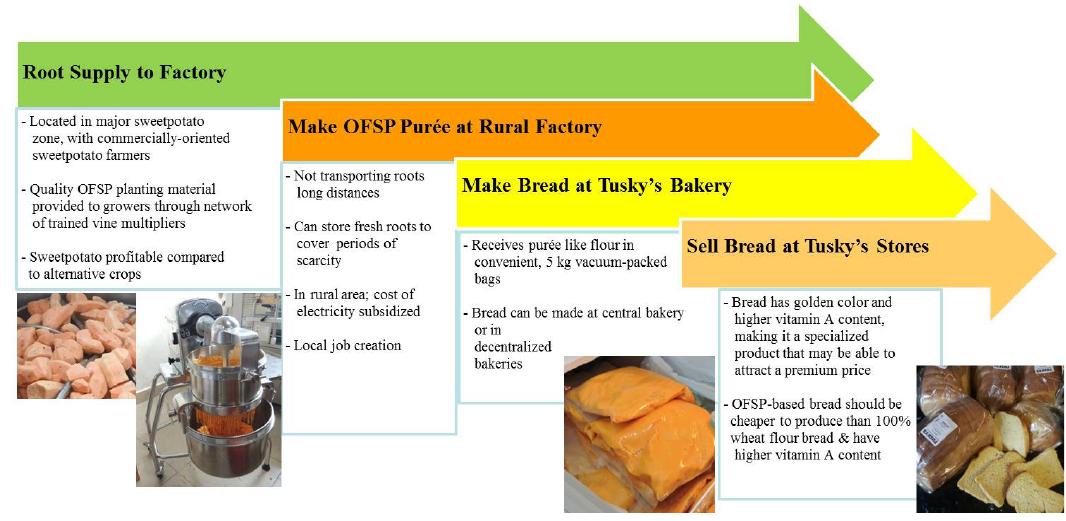
Figure 1: Major Components of the OFSP Purée-Bread Value